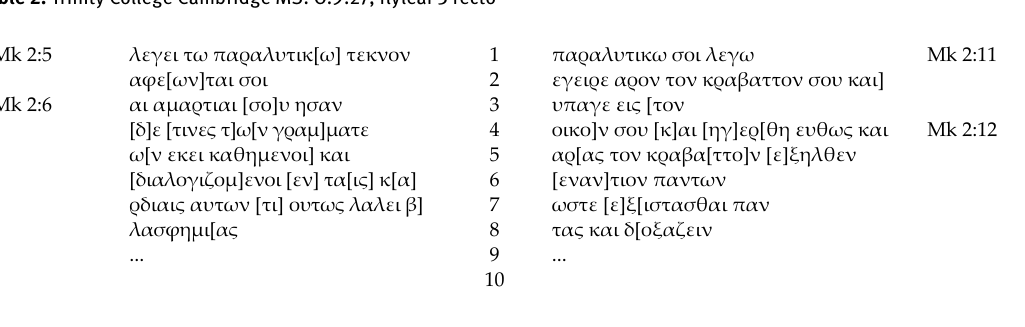
Table 2. Trinity College Cambridge MS. O.9.27, flyleaf 3